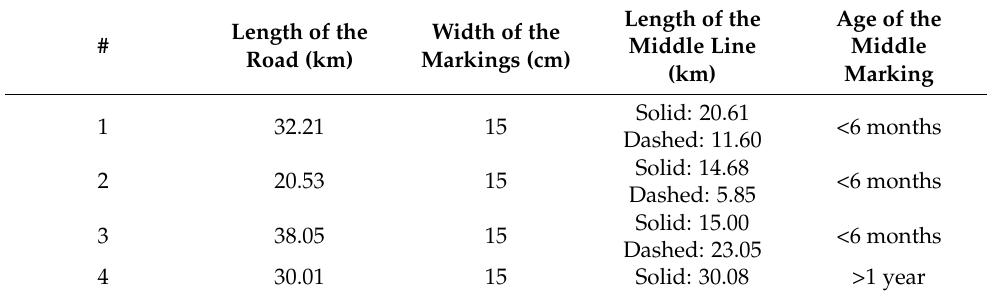
Table 2. Characteristics of tested road